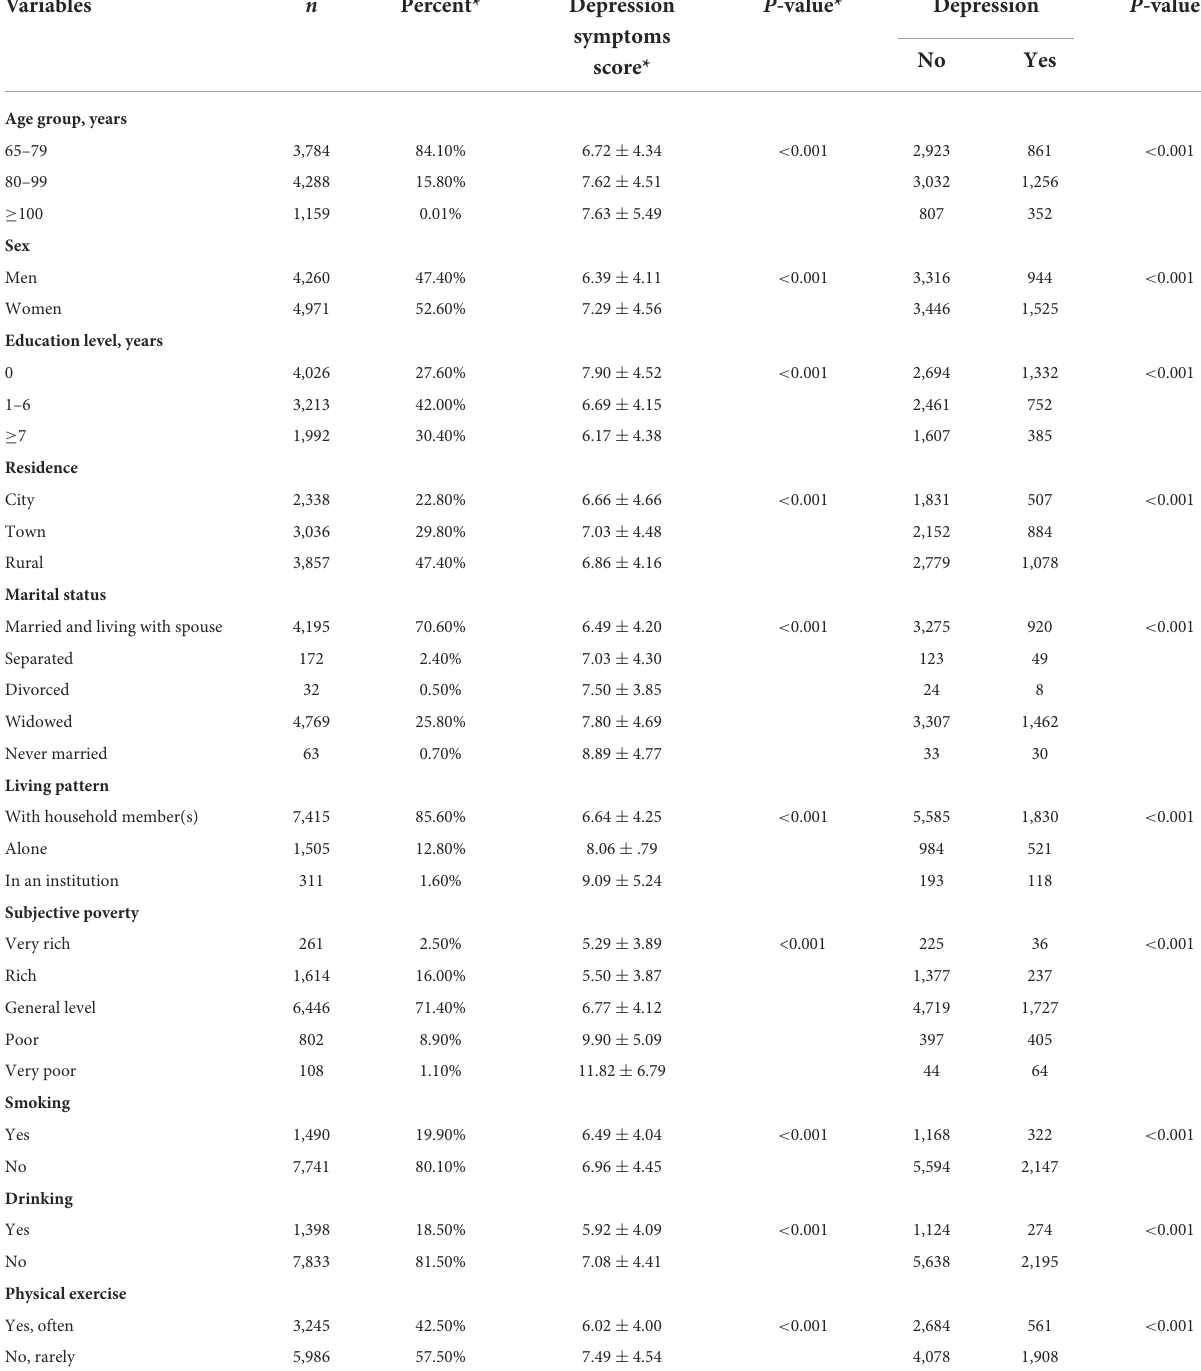
TABLE 1 Describe the characteristics of depressive symptoms in Chinese adults aged 65 years and older.